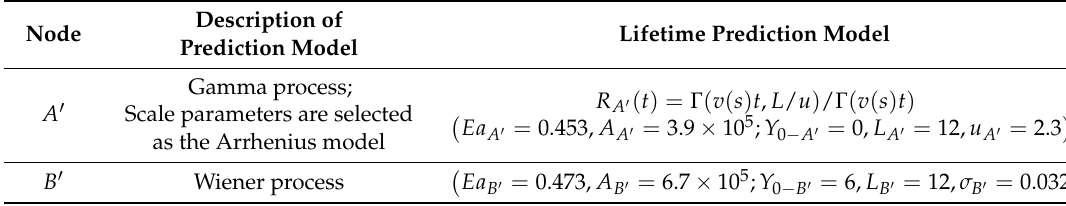
Table 3. Prediction model (2) of four pieces of equipment 1